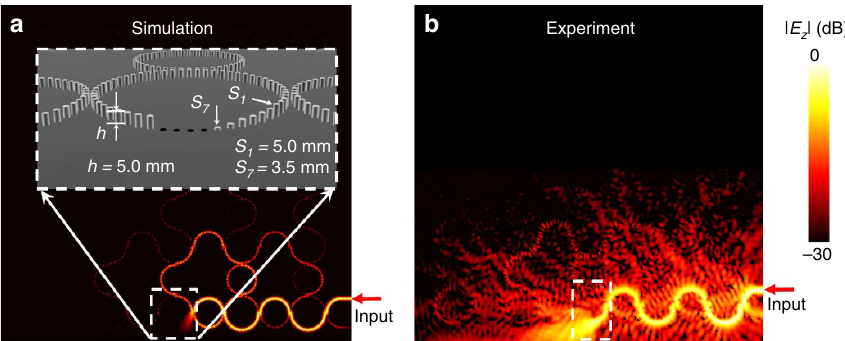
Figure 6 | Demonstration of backscattering-immune strongly dissipative defect. ( a ) Simulated field pattern when metallic rods of a lattice ring gradually decrease their heights to zero (shown in the inset; from s 1 to s 7 , s 1 ¼ 4.7mm, s 2 ¼ 4.1mm, s 3 ¼ 3.5mm, s 4 ¼ 2.9mm, s 5 ¼ 2.3mm, s 6 ¼ 1.7mm and s